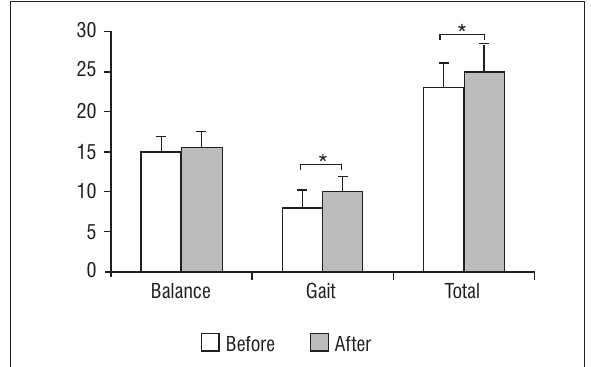
Figure 3 - Tinetti Balance, Tinetti Gait e Tinetti Total, before and after treatment